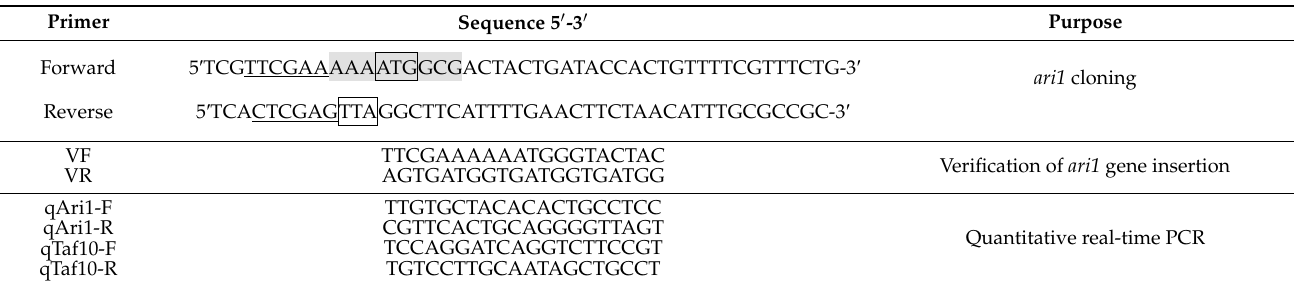
Table 1. Oligonucleotides used in this study.